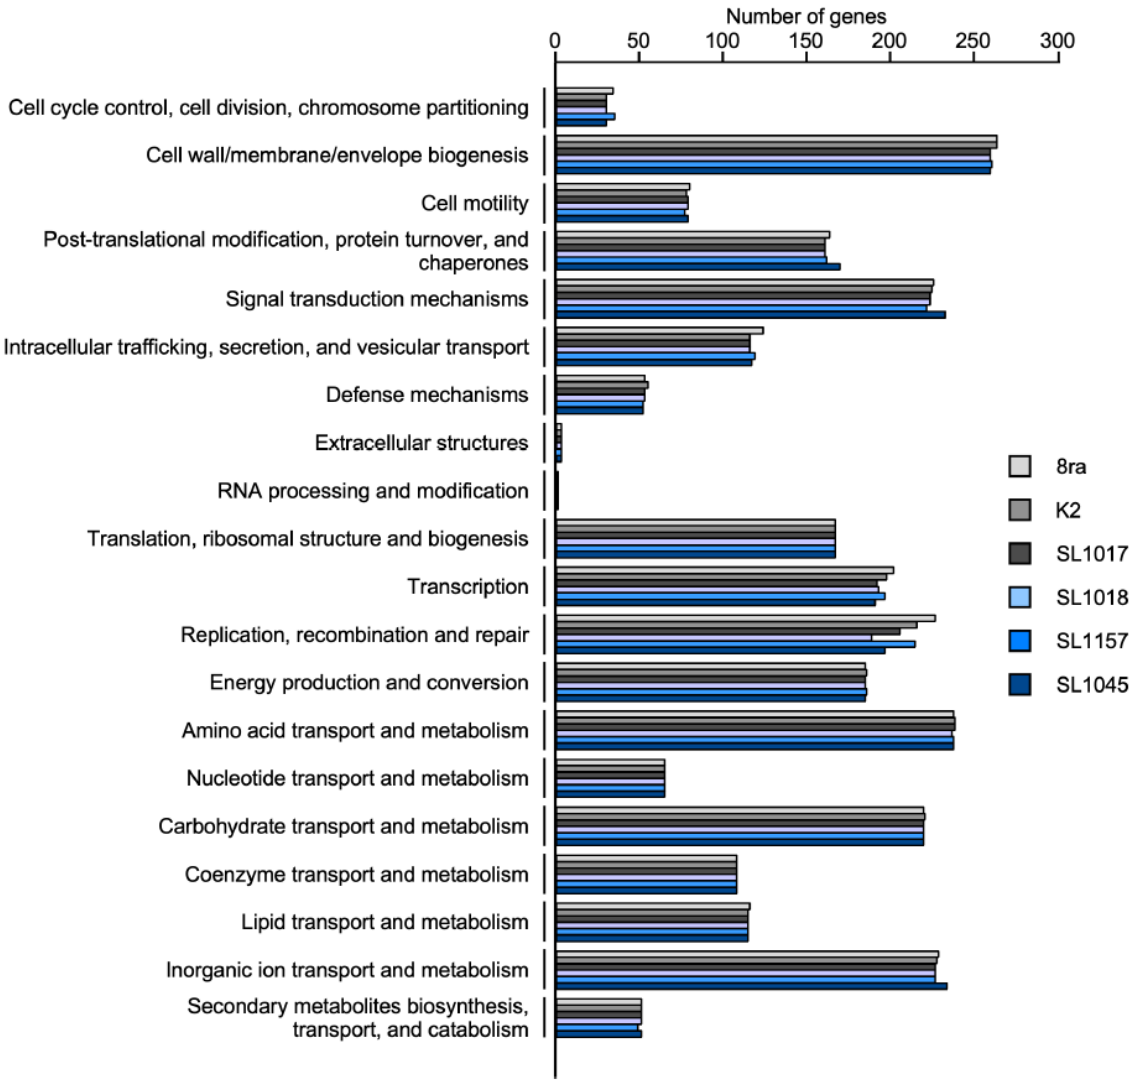
Figure 4. Number of genes in distinct functional categories for the five Korean Xcg strains and the US Xcg strain 8ra. All putative genes were aligned to the database of Clusters of Orthologous Groups (COGs) to predict possible functions. The genes were classified into 21 total COGs. The unknown function category is not shown. Values on the X-axis indicate the number of genes, and the Y-axis labels indicate the COG categories.